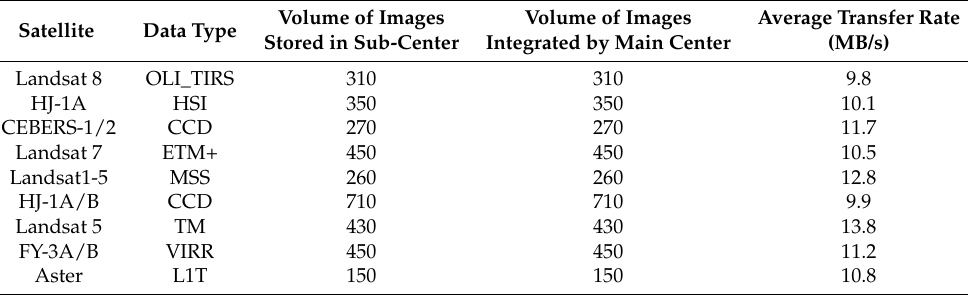
Table 4. Experimental results of distributed data